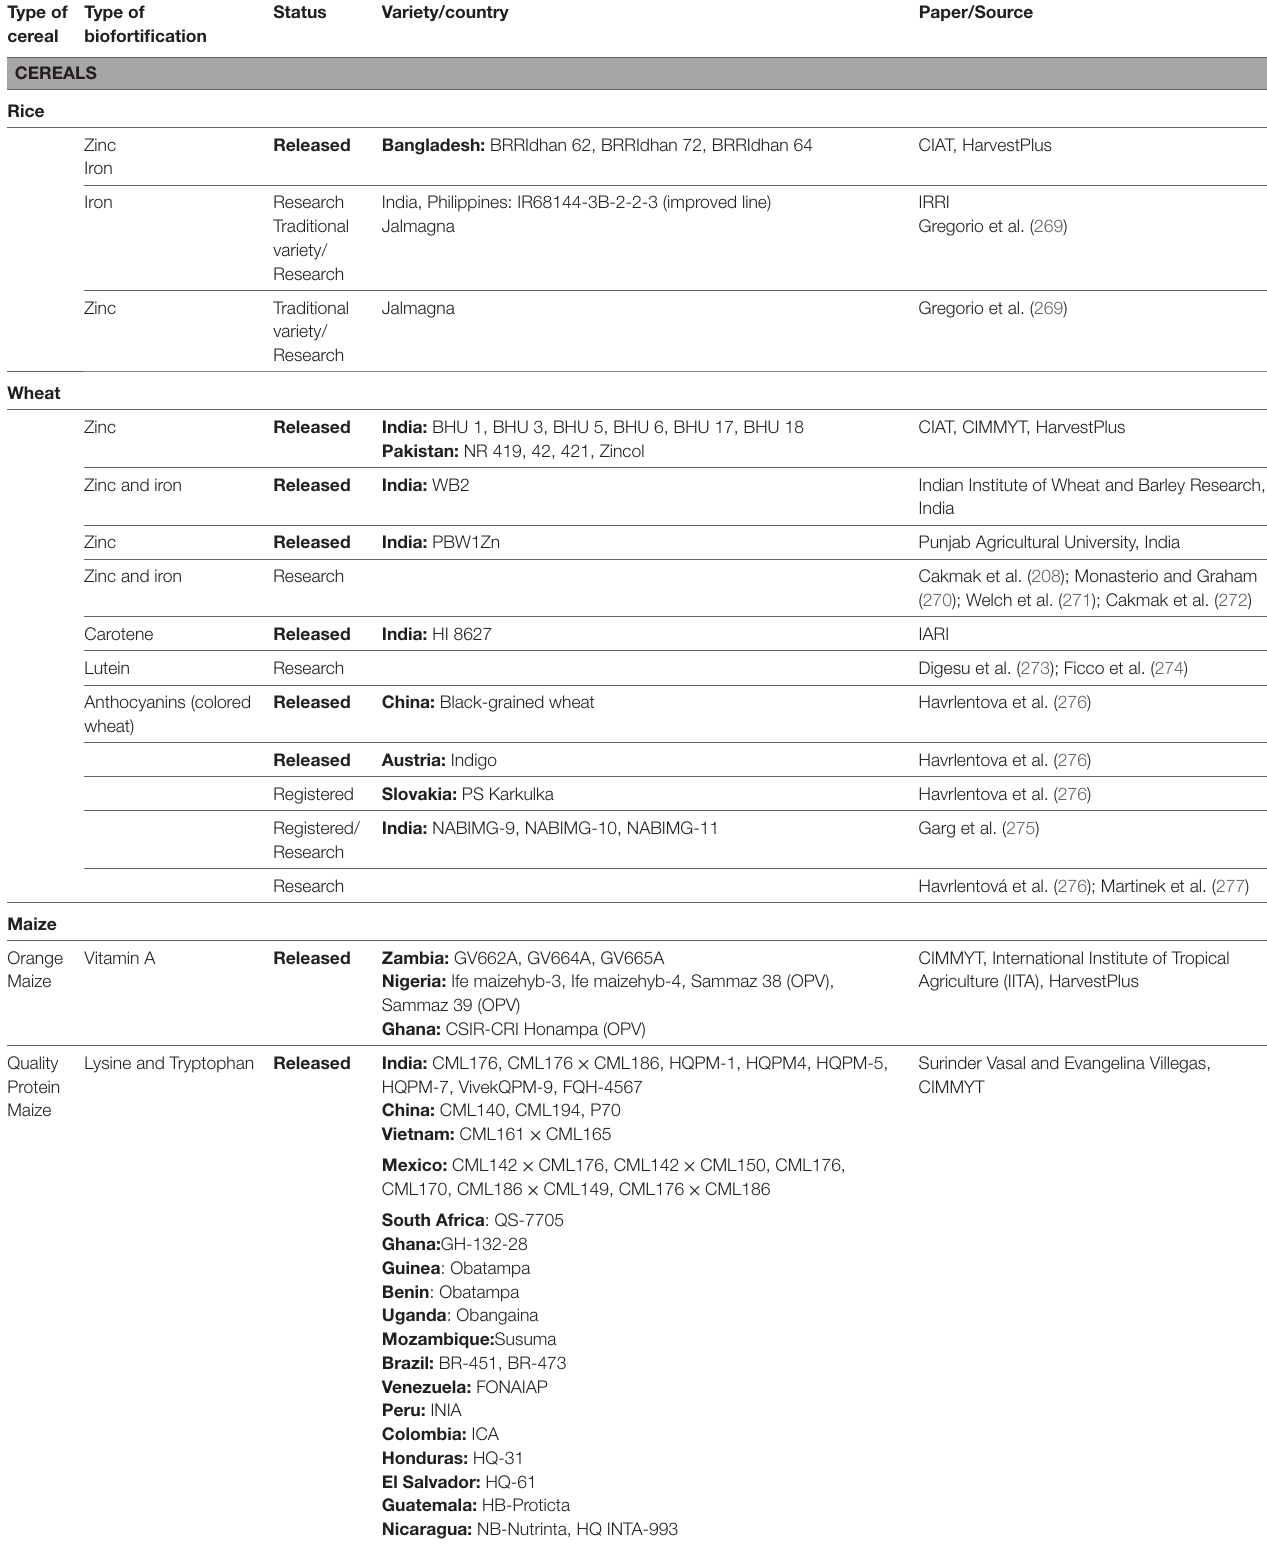
TABLe 4 | Tabulation of crops, nutrients, research status, and concerned publications on biofortification through